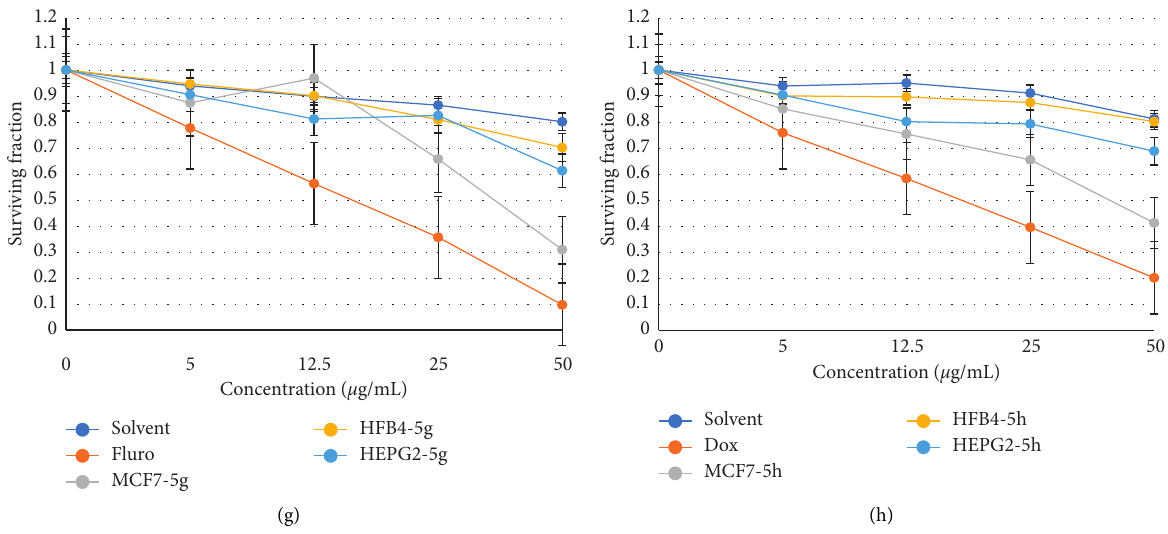
Figure 2: Dose-dependent response of two cell lines cells treated with the derivatives 5a–h determined by MTT assay (48h).